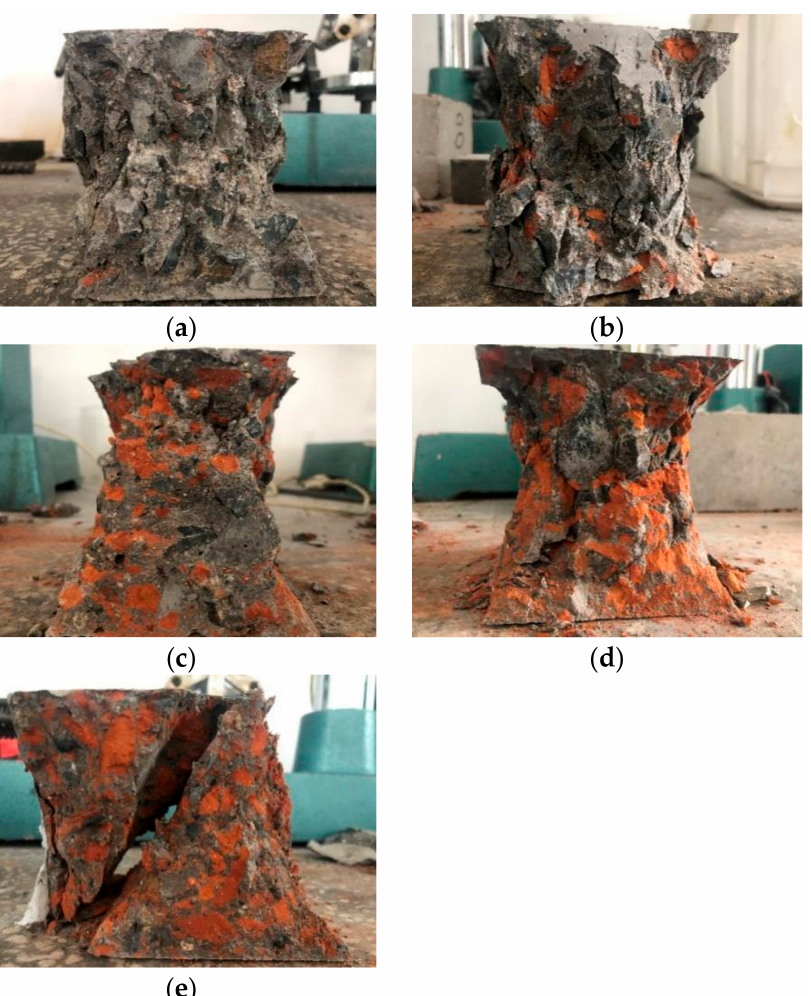
Figure 8. Compression failure mode of RBCA concrete specimens: ( a ) RB-0, ( b ) RB-25, ( c ) RB-50, ( d ) RB-75, ( e )